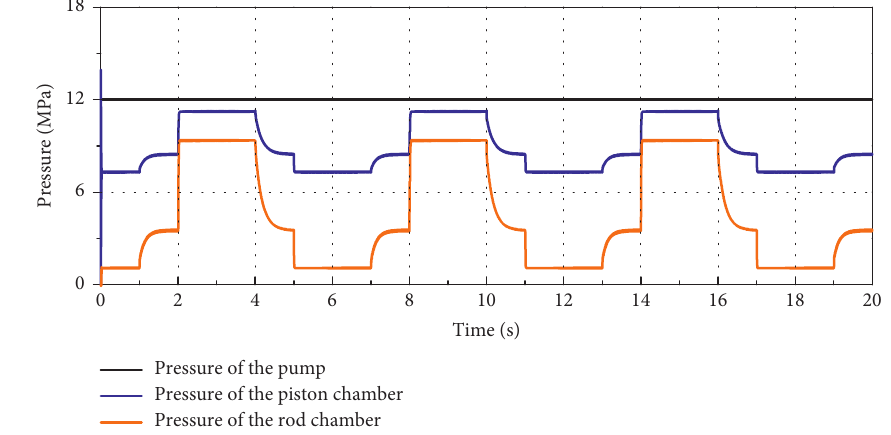
Figure 21: Pressures of system 3 in test 2.